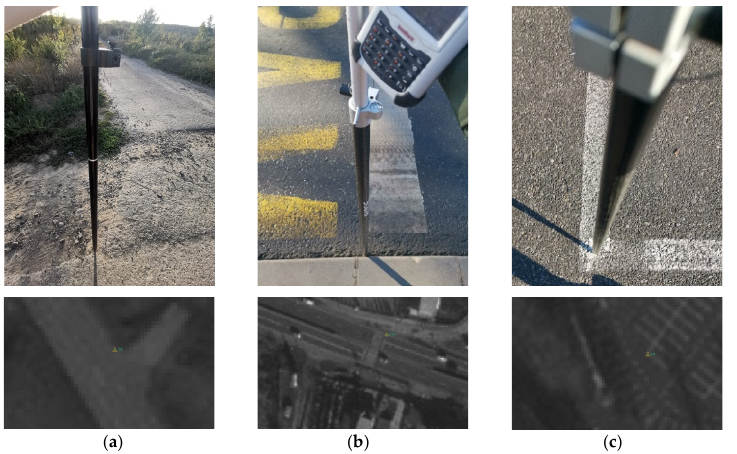
Figure 9. The location of GNSS-RTK measurements in the field and on images: ( a ) road intersection; ( b ) crosswalk and ( c ) parking markings.